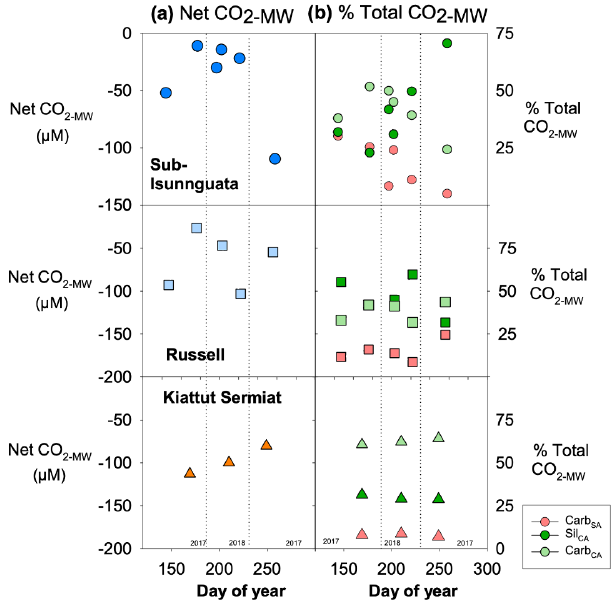
Figure 6. Mineral weathering model results in (a) net impact of mineral weathering reactions on CO 2 (Net CO 2-MW ; Eq. 7) for Isunnguata, Russell, and Kiattut Sermiat subglacial discharge sites (where negative values of Net CO 2-MW indicate net sequestration of CO 2 due to mineral weathering) and (b) the proportional con- tribution of each mineral weathering reaction to the total change in CO 2 (% Total CO 2-MW Eqs. 9a–9c).